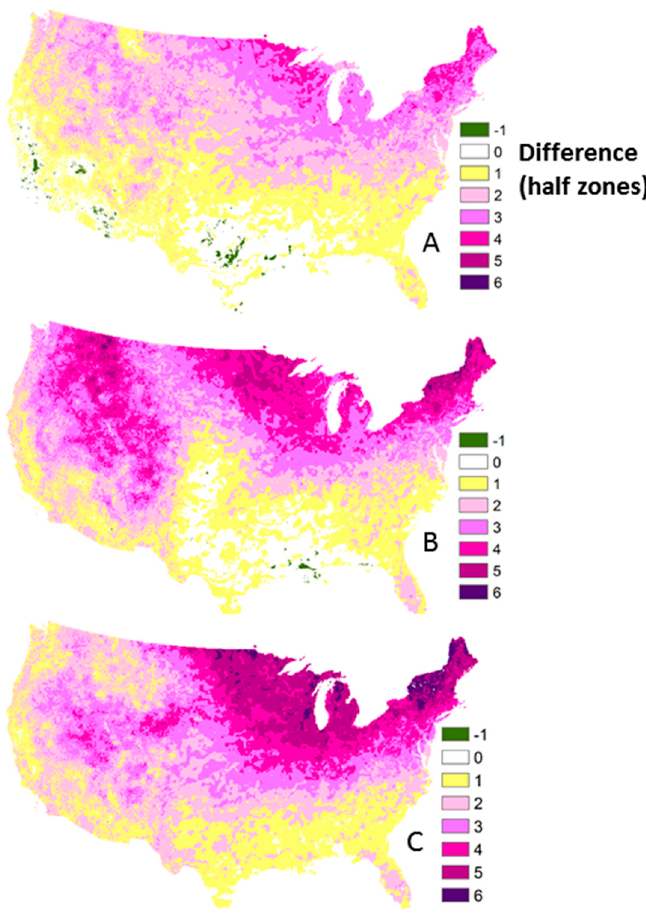
Figure 2. Differences (future–current plant hardiness zone) between current plant hardiness zones and GFDL-ESM2G RCP8.5 plant hardiness zones (panel A ), CanESM2 RCP8.5 plant hardiness zones (panel B ), and HadGEM2-ES RCP8.5 plant hardiness zones (panel C ).